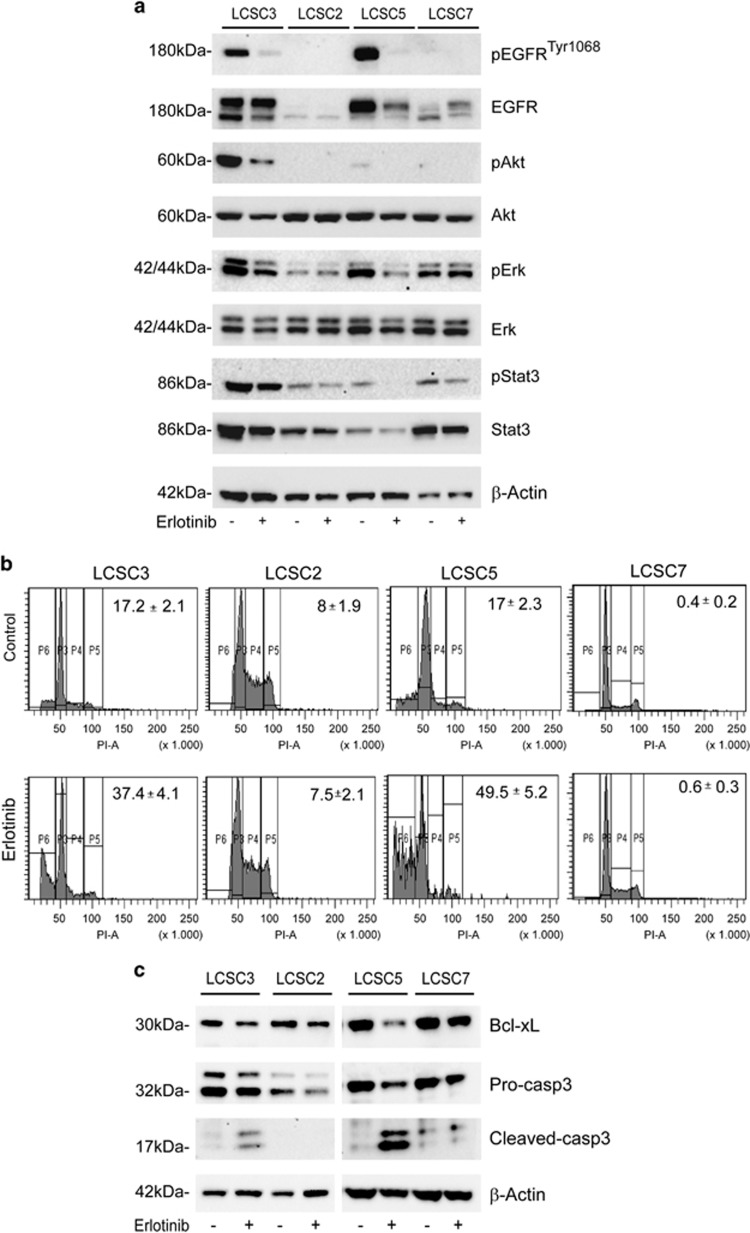
Erlotinib-induced EGFR pathway downmodulation and cell death in sensitive LCSCs. (a) Immunoblot analysis of the indicated EGFR pathway components in control or 2-day erlotinib-treated sensitive (LCSC3 and LCSC5) or resistant (LCSC2 and LCSC7) LCSCs. Flow cytometric quantification of propidium iodide-stained apoptotic cells (b) and immunoblot analysis of Bcl-xL and caspase-3 cleavage (c) in the same cells as in (a) exposed to erlotinib for 3 days. (b) Percentage of subdiploid/apoptotic cells is indicated±S.D.